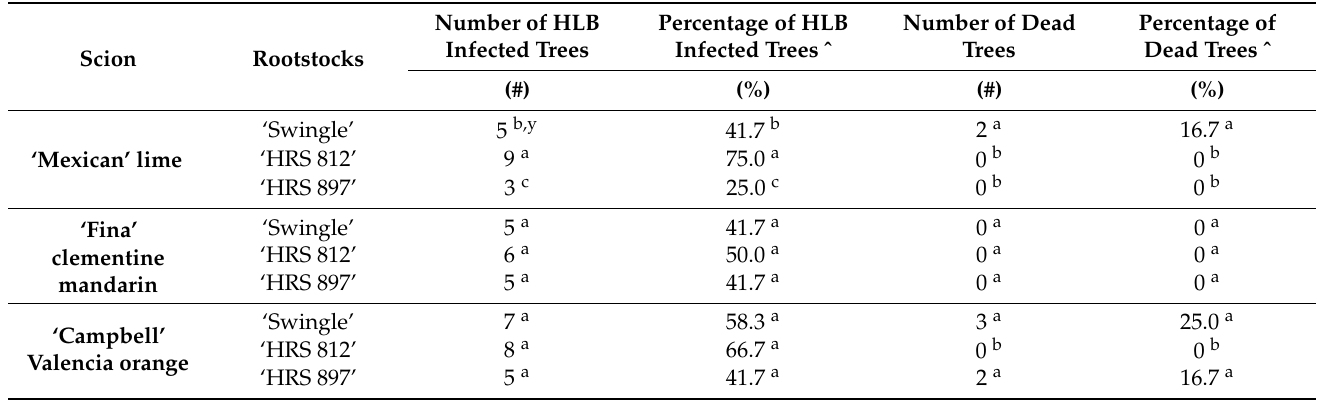
Table 5. Number and percentage of trees infected by and dead due to HLB in